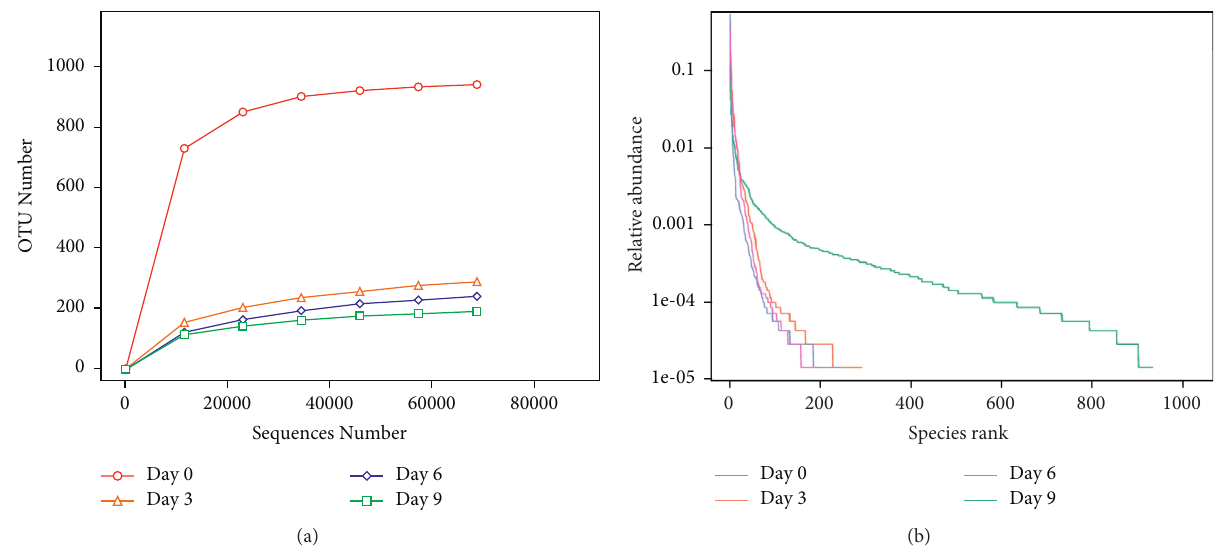
Figure 2: Rarefaction curves (a) and rank abundance curves (b) of bacterial diversity during rainbow trout fillets storage. Table 1: Diversity index of rainbow trout samples stored at 4 ° C for different storage times. Sample ID Shannon